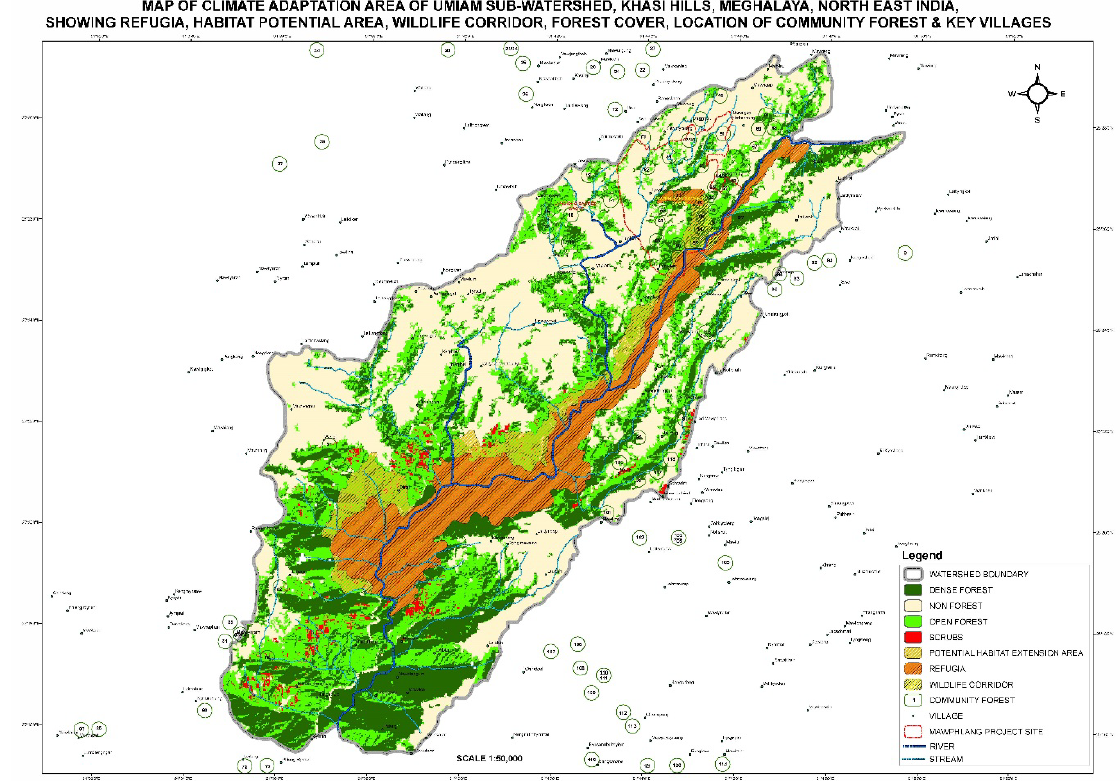
Figure 1. Khasi Hills Community REDD Project Area.